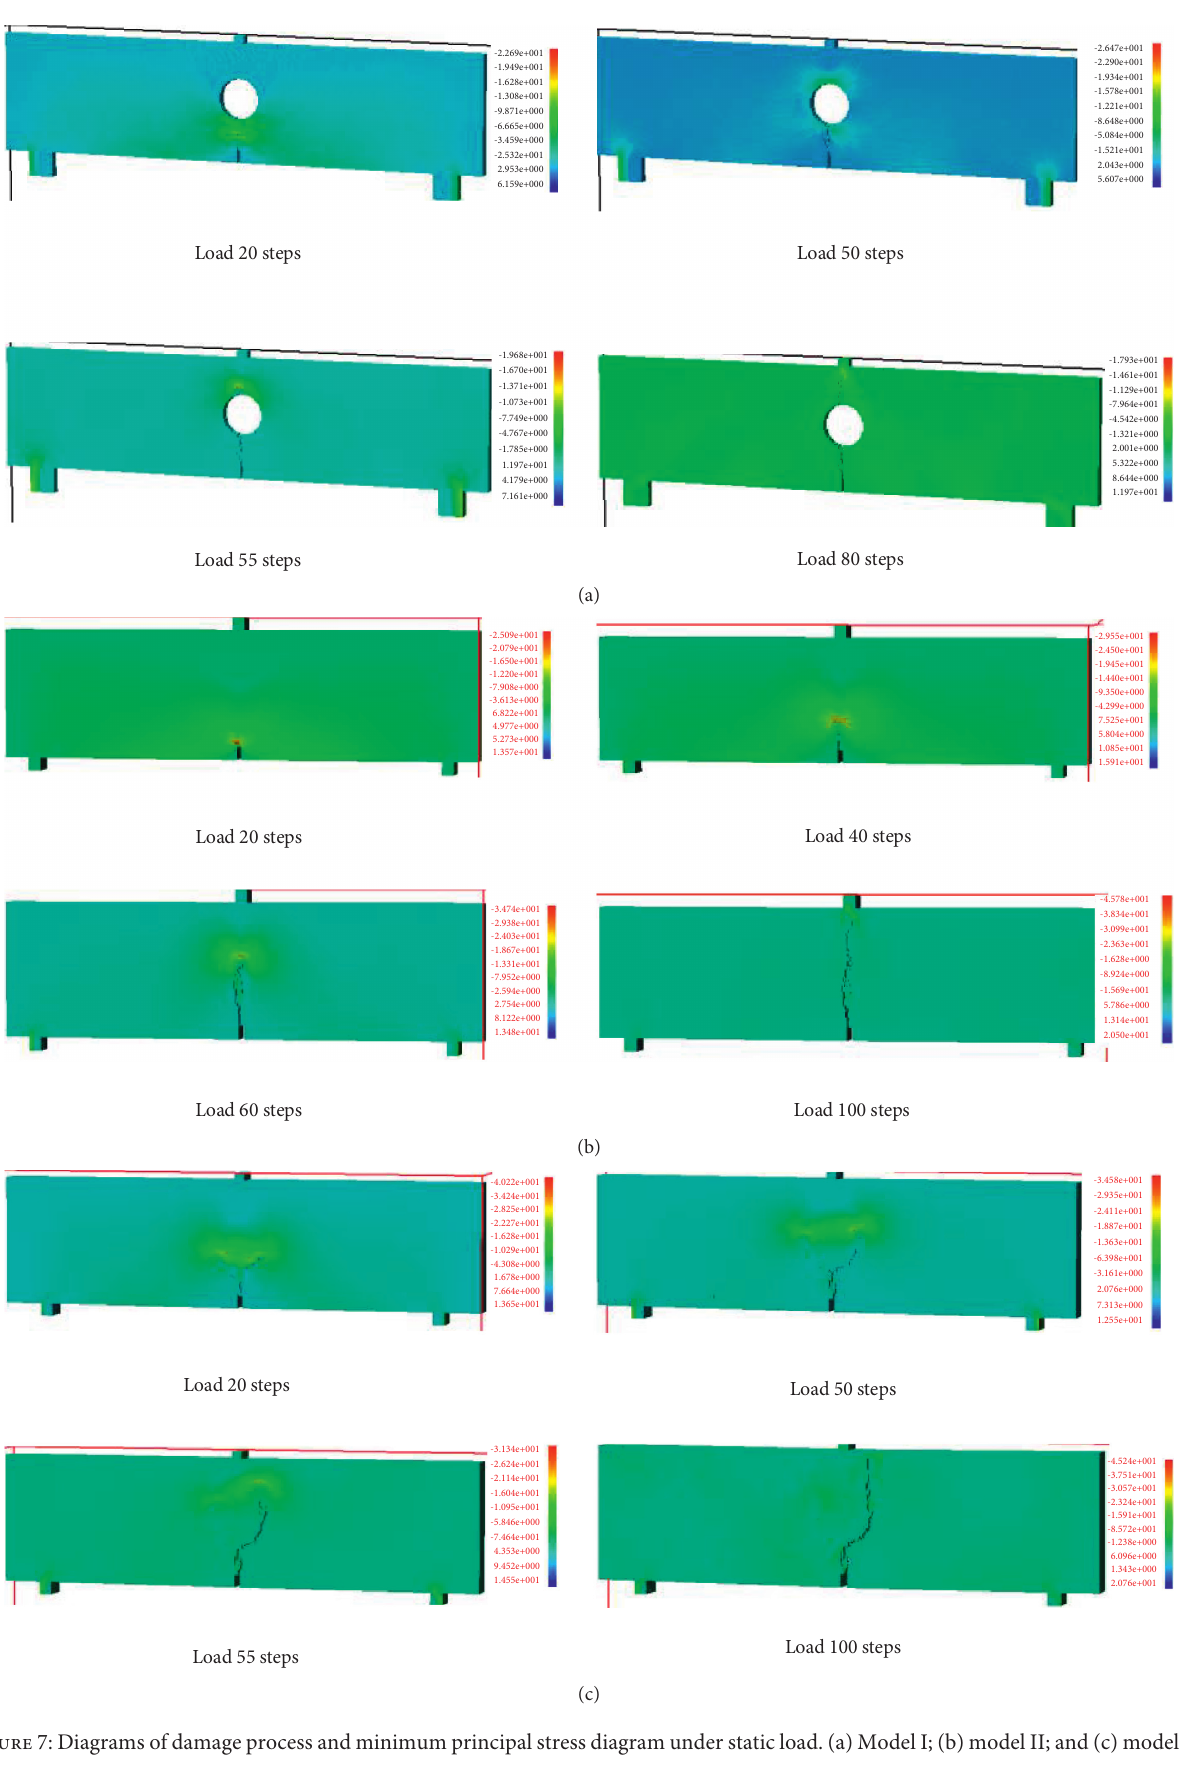
Figure 7: Diagrams of damage process and minimum principal stress diagram under static load. (a) Model I; (b) model II; and (c) model